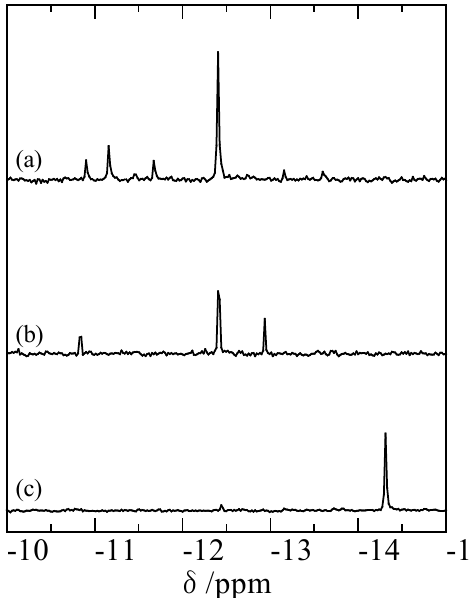
Figure 3. 31 P NMR spectrum of a 100 mM W(VI)–500 mM P(V)–V(V)–pH 2.0